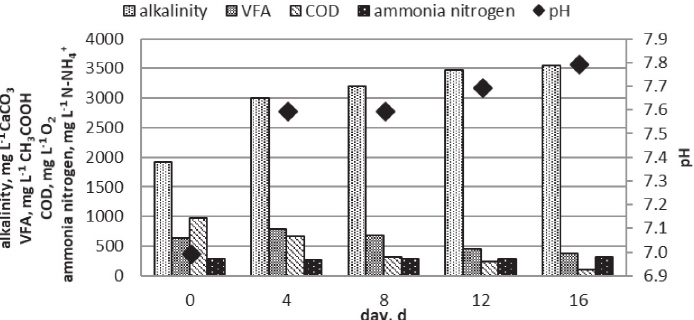
Fig. 1 – changes in the concentration of VFA, alkalinity, CODdiss, ammonia nitrogen, and pH in municipal sludge during anaerobic digestion (mixture K)